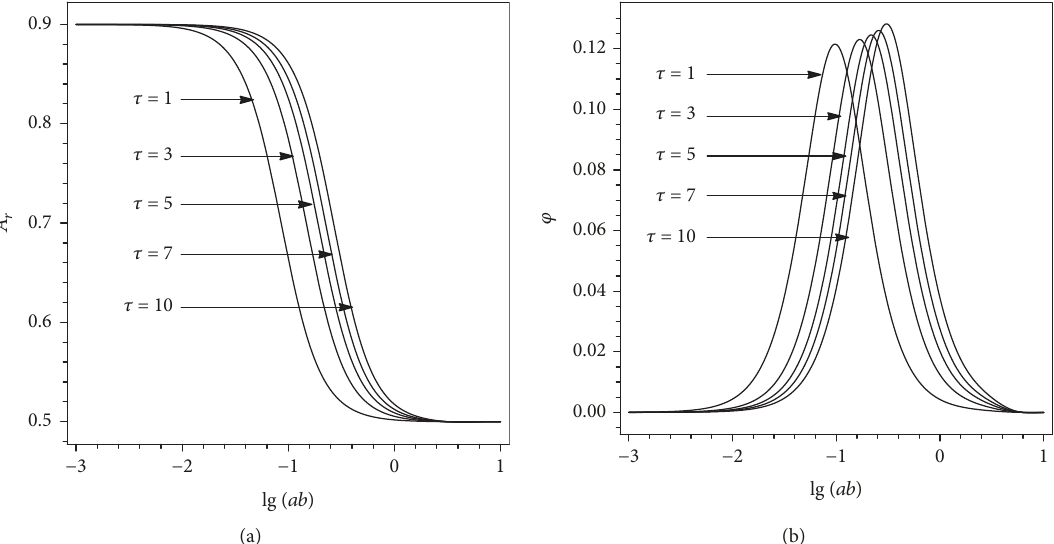
Figure 6: Changes of (a) amplitude ratio A of τ ( τ = b / b ′ ). The loading coe ffi cients L Table 2: Fixed parameters and their values used in the discussion. Case no.